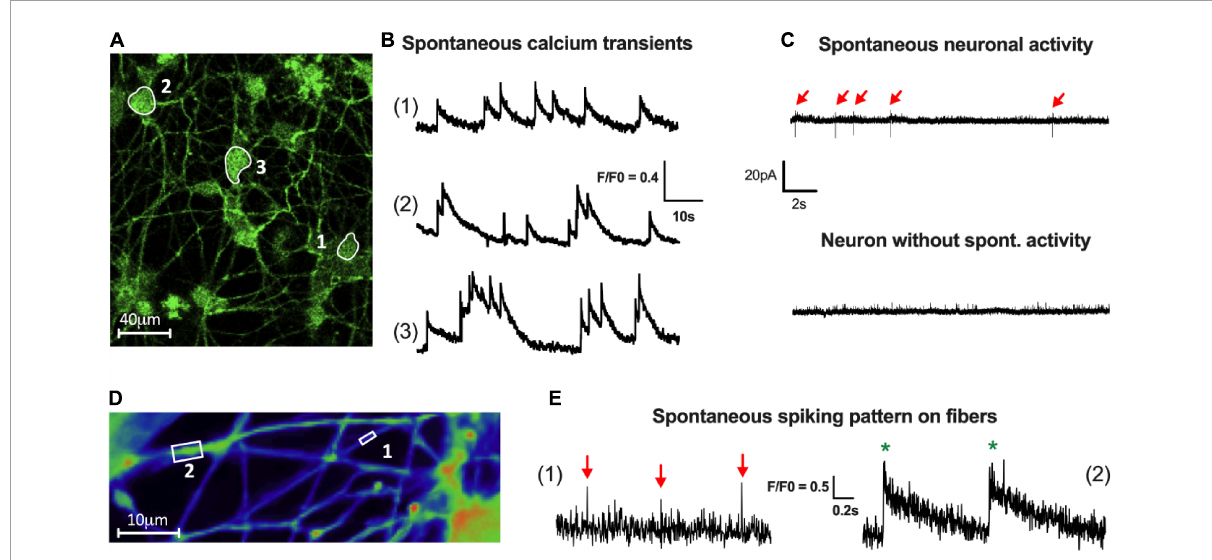
FIGURE5 Activity of enteric neurons within the network. (A,B) Fluorescence images (A) of a field containing neuronal cell bodies with spontaneous activity (1, 2 and 3). (B) Representative traces of three types of spontaneous Ca 2 + activity defined as isolated (1), moderately clustered (2) and tightly clustered transients (3) (70 neurons analyzed from n = 4 cultures from 4 independent rat embryos). (C) Representative traces of spontaneous spiking pattern in patch clamp cell-attached configuration (15 neurons analyzed from n = 5 cultures from 5 independent rat embryos). (D) Fluorescence images of a field containing neuronal fibers of small (boxed region 1) and large (boxed region 2) caliber with spontaneous activity visualized by VSD imaging. (E) Representative traces of isolated spikes (red arrow) on small caliber fibers (1) or compound potentials (green*), composed of several spikes, on large caliber fibers (2) (15 fibers analyzed from n = 4 cultures from 4 independent rat